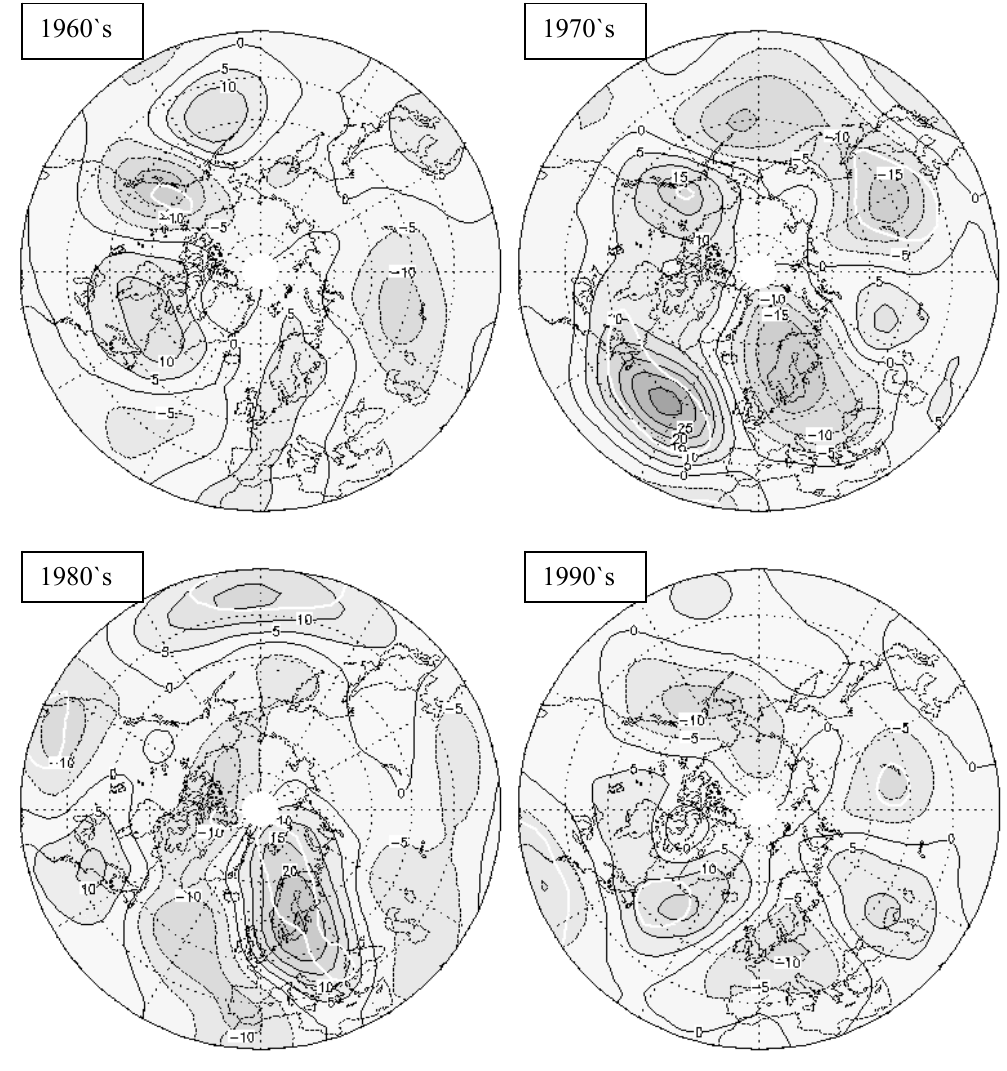
Figure 2: same as Figure 1, but for January. Fig. 2. Same as Fig. 1, but for